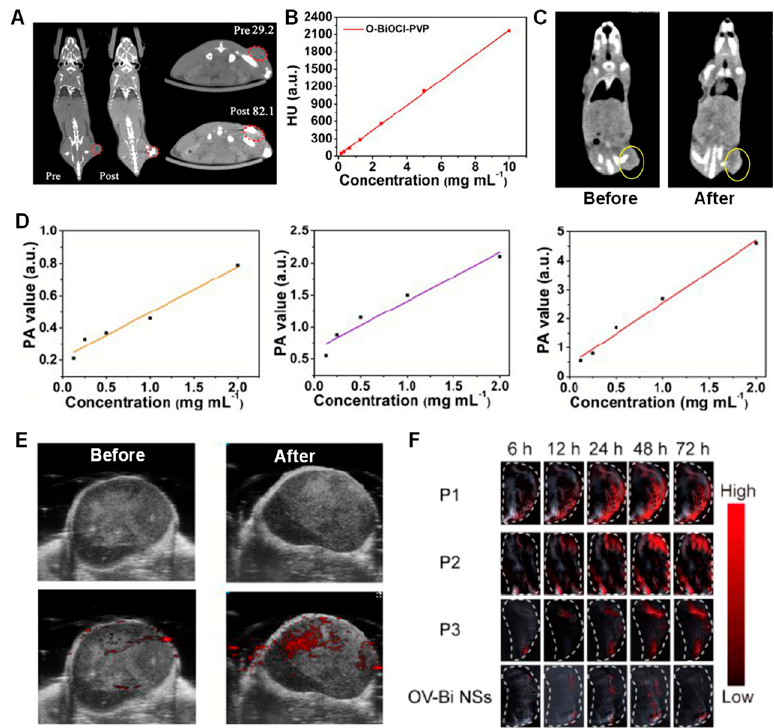
Figure 5. CT and PA imaging abilities of BiOCl NMs. ( A ) The CT images of front view and side view with and without injected Se-doped BiOCl. Reproduced with permission from Ref. [64], 2019, American Chemical Society; ( B , C ) in vitro and in vivo CT imaging ability of oxygen-vacancy-rich BiOCl; ( D ) PA signals of OBP-1, OBP-2, and OBP-3; ( E ) PA imaging of 4T1 tumor-bearing mice before and after intratumoral injection of oxygen-vacancy-rich BiOCl. Reproduced with permission from Ref.